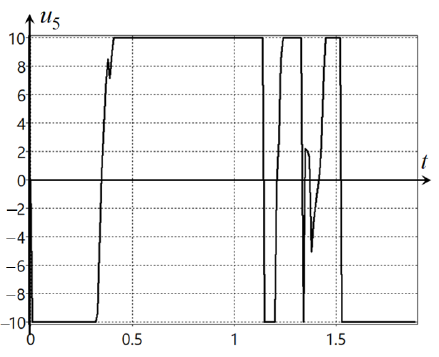
Figure A11. Plot of optimal values of control component u 5 .